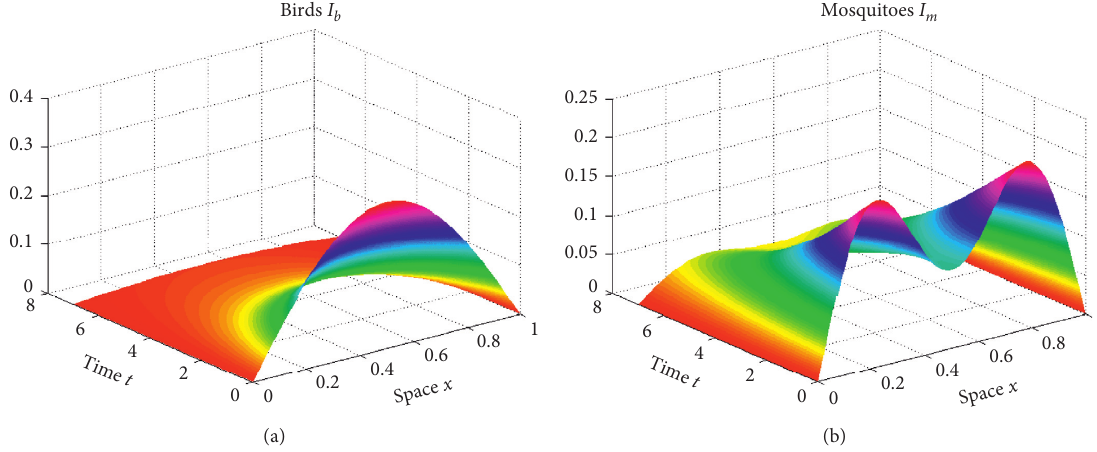
Figure 3: ρ ( t ) � 1. R ( 1 ) < 1, which implies that the solution decays quickly to zero in a fixed domain. 0 00.050.10.150.20.250.30.35